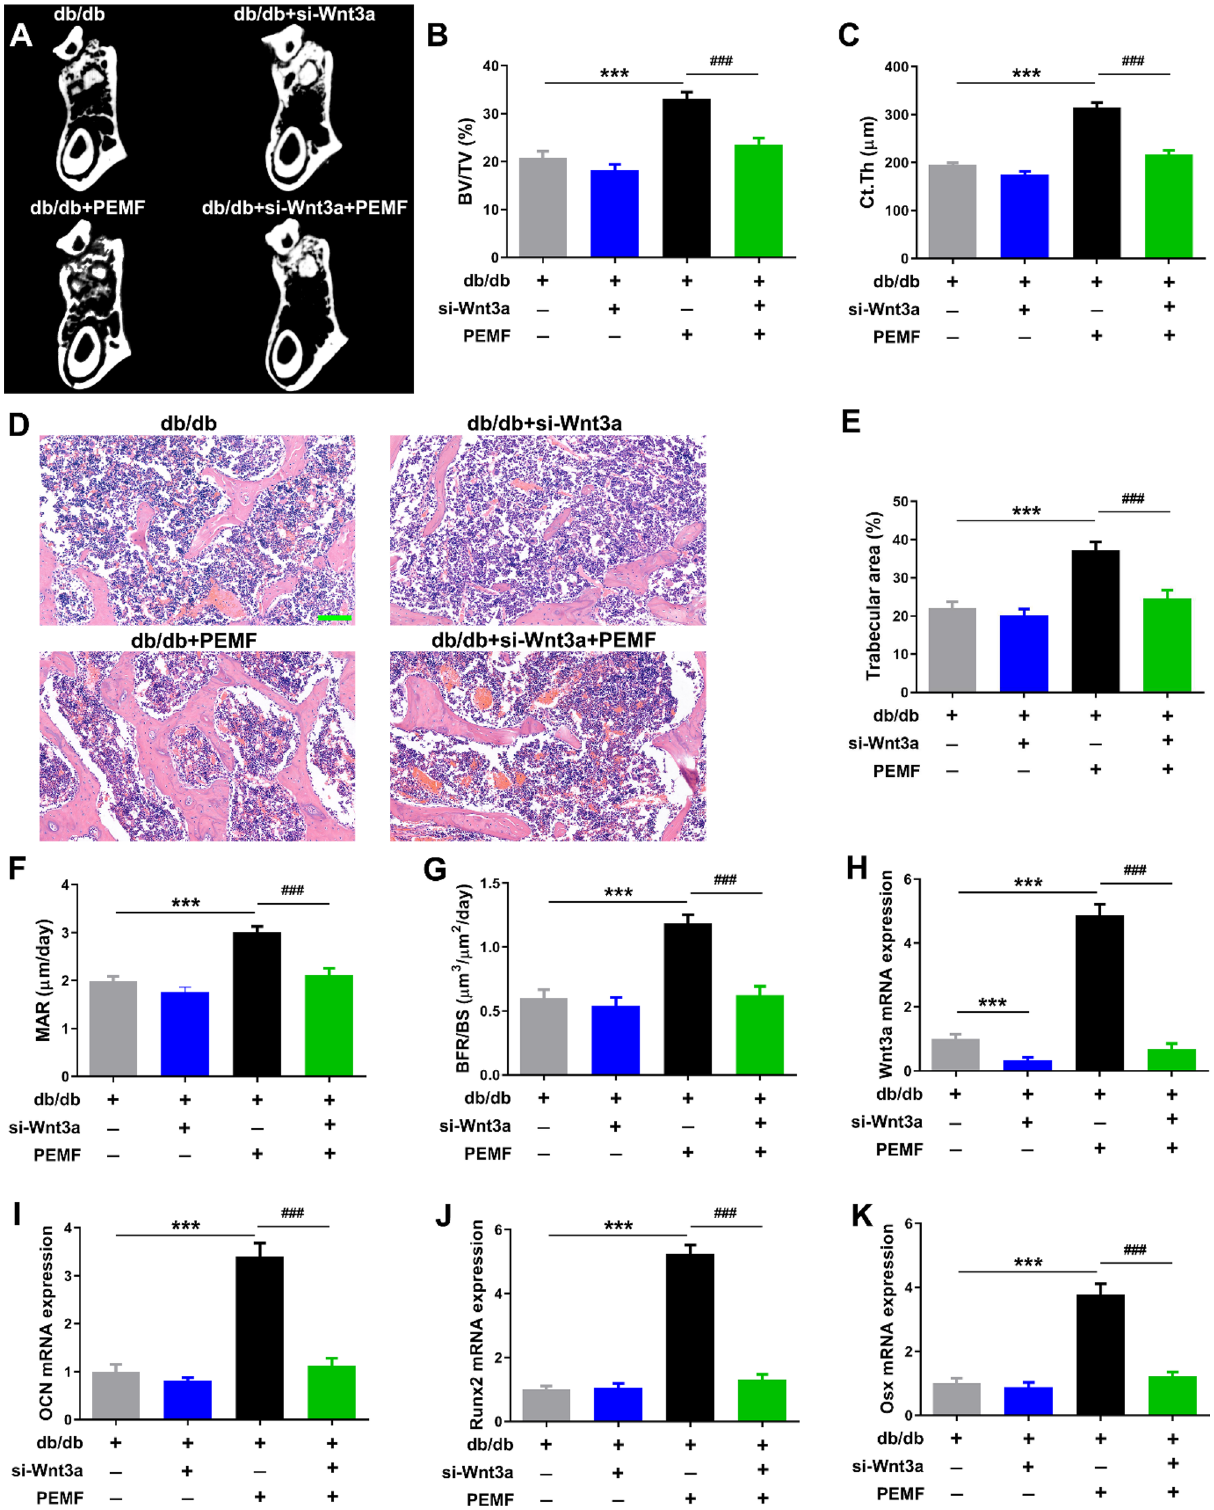
Figure 7. Wnt3a silencing blunts pulsed electromagnetic fields (PEMF)-induced improvement in mandibular bone microarchitecture, bone formation and osteoblastic activity in db/db mice in vivo. ( A–C ) Analysis of mandibular bone microarchitecture based on micro-CT imaging. (D,E) Analysis of mandibular trabecular bone microstructure based on H&E staining. Scale bar represents 100 µm. ( F,G ) Analysis of mandibular trabecular bone formation rate based on calcein double-labeling imaging. ( H–K ) Analysis of Wnt3a and osteoblastic differentiation-related gene expression in mandibular bone, including osteocalcin, Runx2 and Osx. Data are represented as mean ± SEM ( n = 8/group). *** P < 0.001 vs. the db/db mice group; ### P < 0.001 vs. the db/db mice with PEMF exposure group by one way analysis of variance (ANOVA) followed by Bonferroni’s multiple